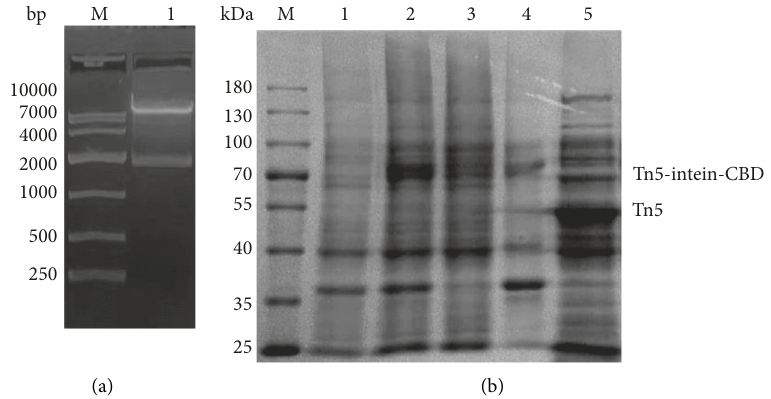
Figure 1: Expression and purification of Tn5 protein. (a) Ptxb1-Tn5 plasmid identification. M Marker; line 1: plasmid digested by Xbal/ BamHI. (b) Expression and purification of Tn5 protein by SDS-PAGE electrophoresis, wild-type Tn5 and higher-molecular weight Tn5- intein-CBD is seen above. M Marker; line 1: crude lysate before IPTG induction; line 2: sonication supernatant; line 3: flow-through; line 4: elution after magnetic beads; line 5: DTT eluted fractions.